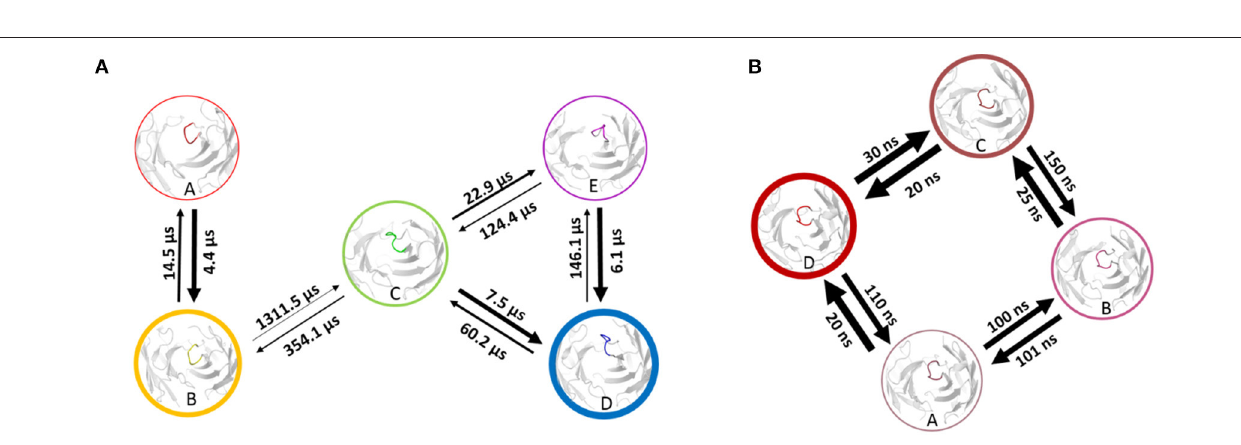
Frontiers in Immunology |